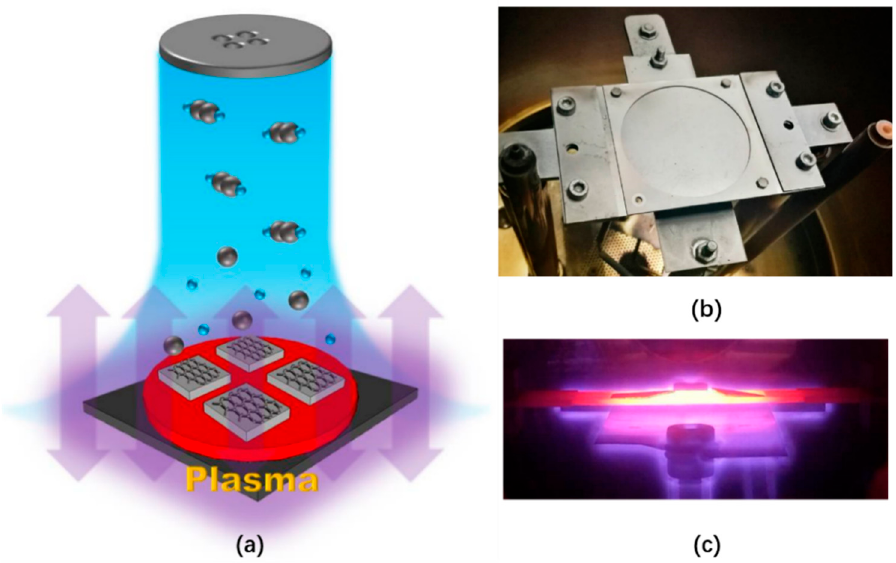
Figure 1. ( a ) The graphene growth schematic. The gas ratio was acetylene:argon = 100:250. We used 40 W-direct current (DC) plasma to assist the growth, which occurred over 25 min at 600 ◦ C and 6 mbar. ( b ) The actual setup of the growth chamber, where the plasma was ignited between the graphitic heater and another graphitic electrode beneath. The round area in the middle of the heater is 2 inches in diameter. ( c ) A photo taken during plasma-enhanced chemical vapor deposition (PECVD), showing the glow map.